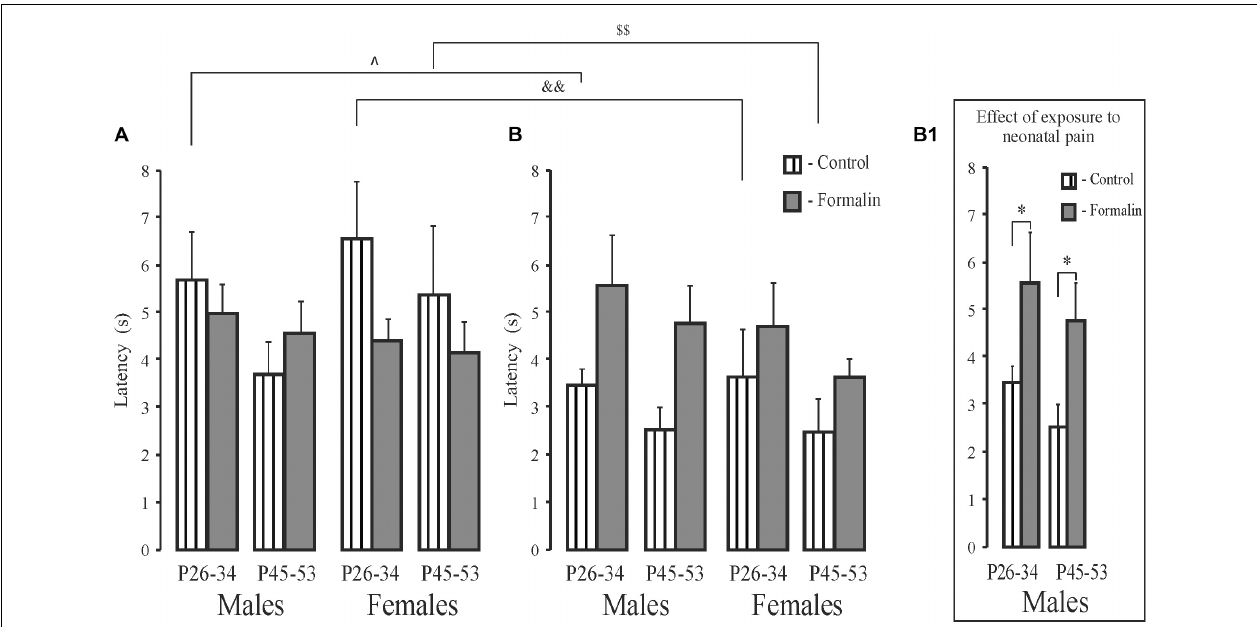
FIGURE 4 | Mean ( ± SEM) latency to find the platform (A,B) for short-term (A) and long-term (B) spatial memory in the Formalin or Control male and female rats for the early (P26-34) and late (P45-53) age groups. Differences in latency between short-term and long-term memory were found in the Control male and female rats of the early age group and in females of the late age group. Formalin vs Control rats; differences between short- and long-term memory: in latency, ∧ p < 0.05, && p < 0.01, in Control P26-34 males and females, and $$ p < 0.001, in Control P45-53 females. The number of the rats in the groups corresponds to the number of rats in the groups in Figures 1 , 2 . The graphs on the right illustrate significant results of statistical analysis. ∗ p < 0.05 significant effect of